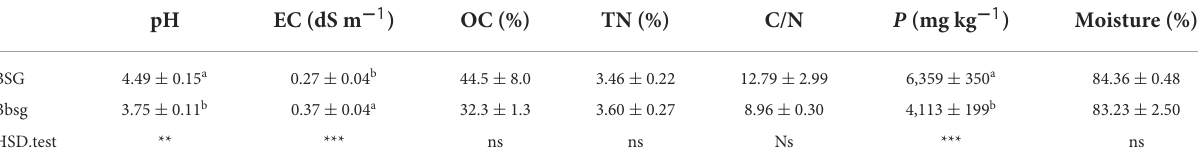
TABLE 1 Chemical and physicochemical characteristics of native (BSG) and bioprocessed brewers’ spent grains (bBSG).